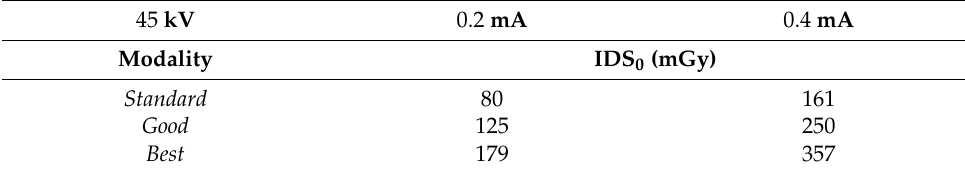
Table 8. IDS 0 reference values provided by the Albira’s manufacturer.